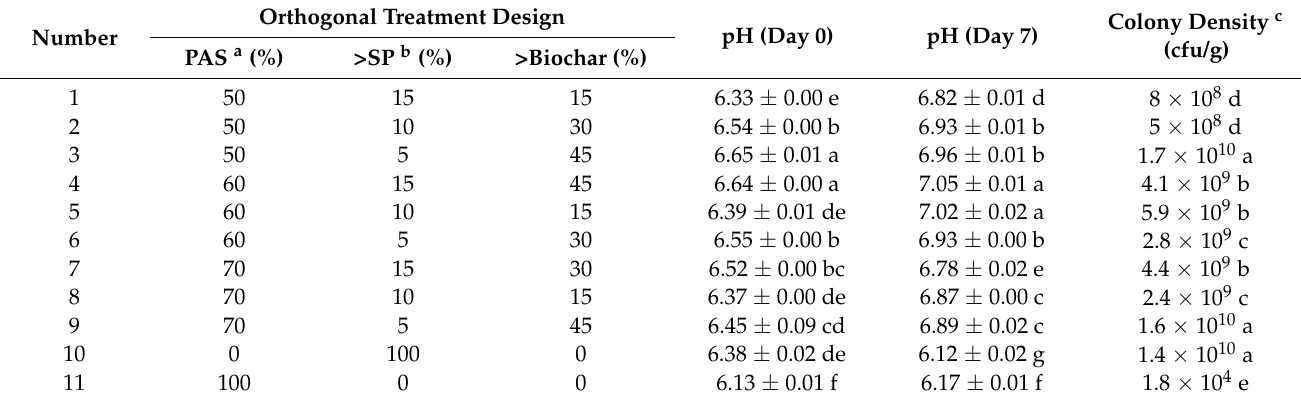
Table 1. The results of PAS fermentation with B. subtilis inoculation and biochar